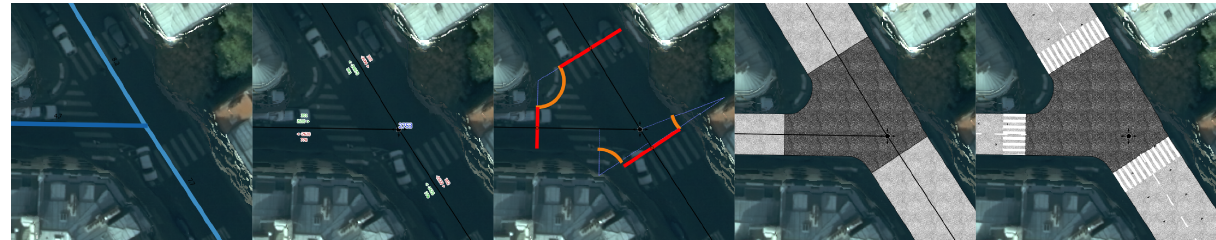
Figure 1: StreetGen in a glance. Given road axes, reconstruct network, find corner arcs, compute surfaces, add lanes and markings.